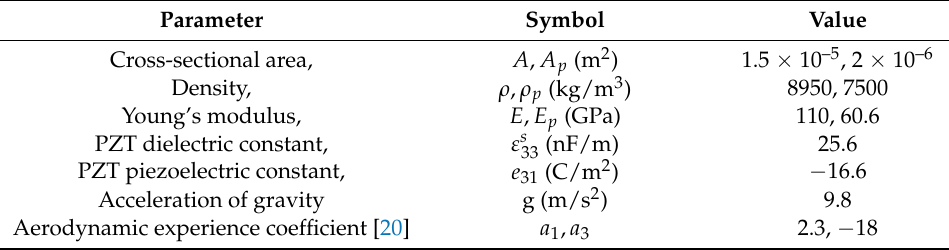
Table 2. Material property parameters and other correlation